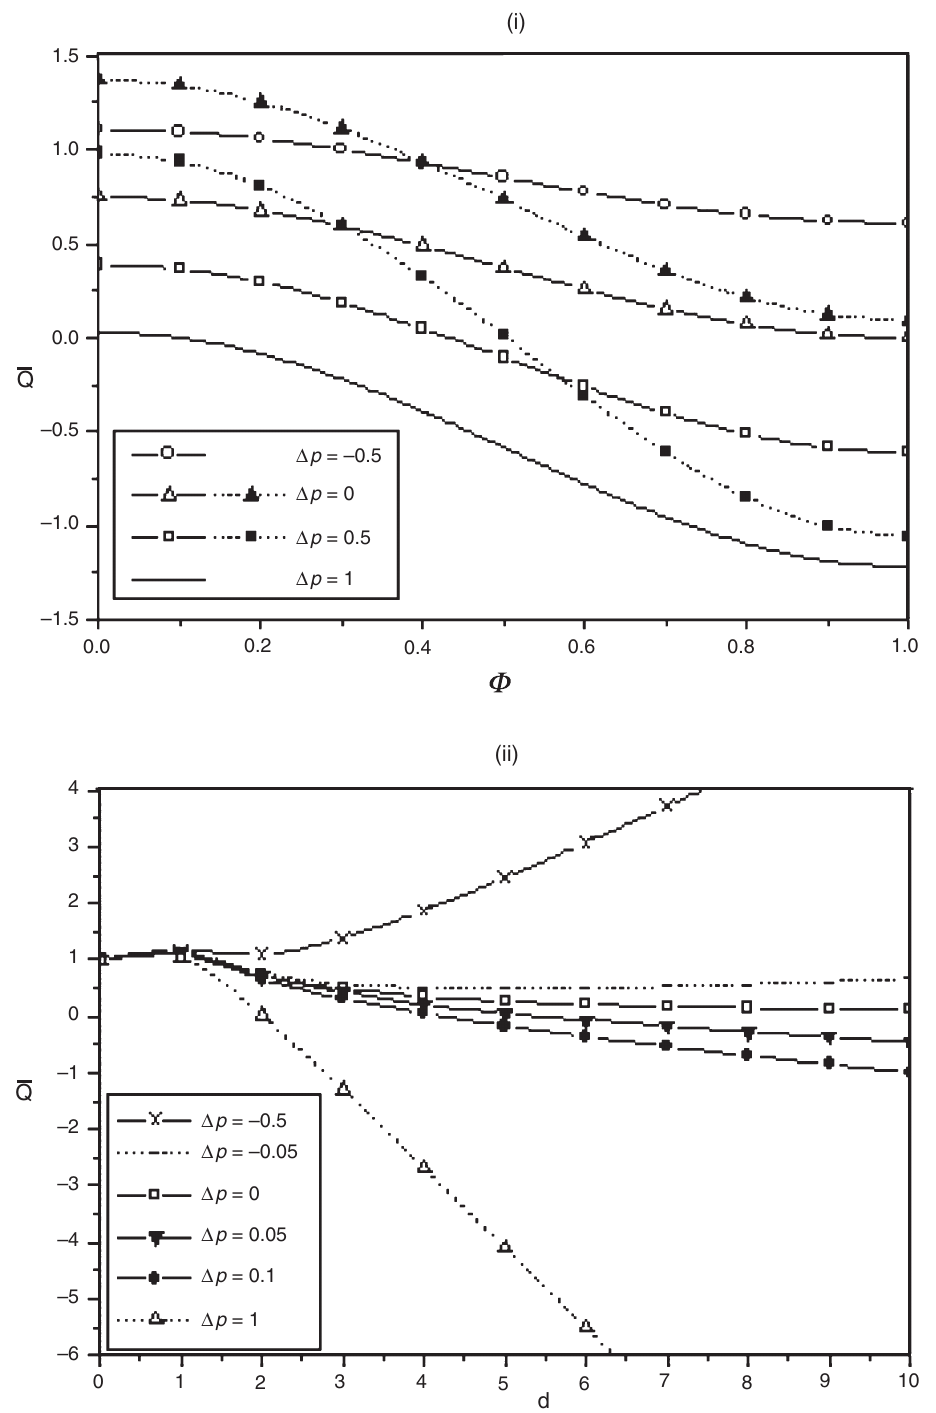
Fig. 7. (i) Variation of Q with φ when d =2, β = 0 . 5 for different values of (cid:9)p at a = b =0.7 (solid lines) and a =0.7; b =1.2 (dot lines). (ii) Variation of Q with d for different (cid:9)p with a = 0 . 7 ,b = 1 . 2 β = 0 . 5, and φ = π/